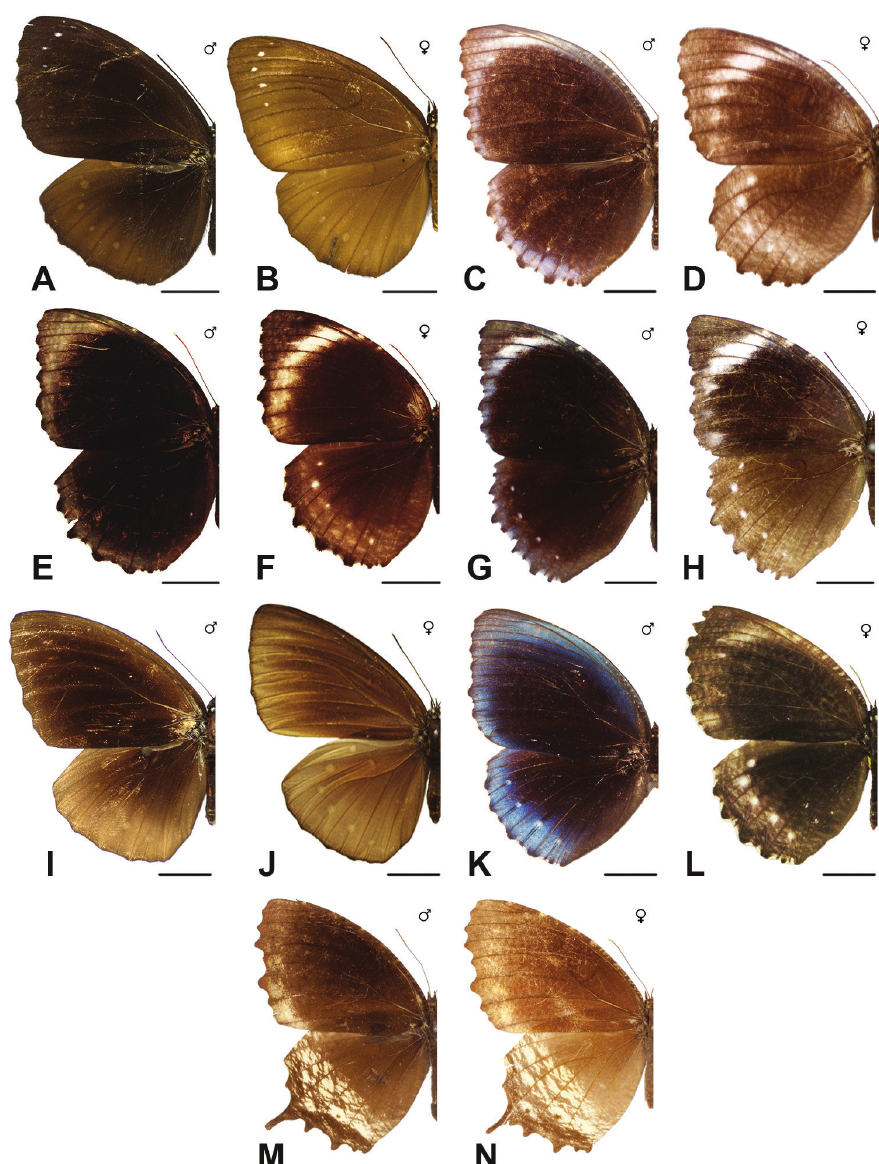
Figure 21. A holofernes ♂ D NHM Papua New Guinea: New Britain B holofernes ♀ D NHM Papua New Guinea: New Britain C bornemanni ♂ D NHM Indonesia: Central Sulawesi, Banggai D bornemanni ♀ D NHM Indonesia: Central Sulawesi, Banggai E phrikonis ♂ D NHM Indonesia: Sula Archipelago F phrikonis ♀ D NHM Indonesia: Sula Archipelago G sangira ♂ D NHM Indonesia: North Sulawesi, Talaud H sangira ♀ D NHM Indonesia: North Sulawesi, Talaud I umbratilis ♂ D NHM Indonesia: Papua, Biak; Holotype J umbratilis ♀ D OPC Indonesia: Papua, Biak K resplendens ♂ MCZ Indonesia: Central Sulawesi, Palu L resplendens ♀ MCZ Indonesia: Central Sulawesi, Palu M singhala ♂ D NHM Sri Lanka N singhala ♀ D NHM Sri